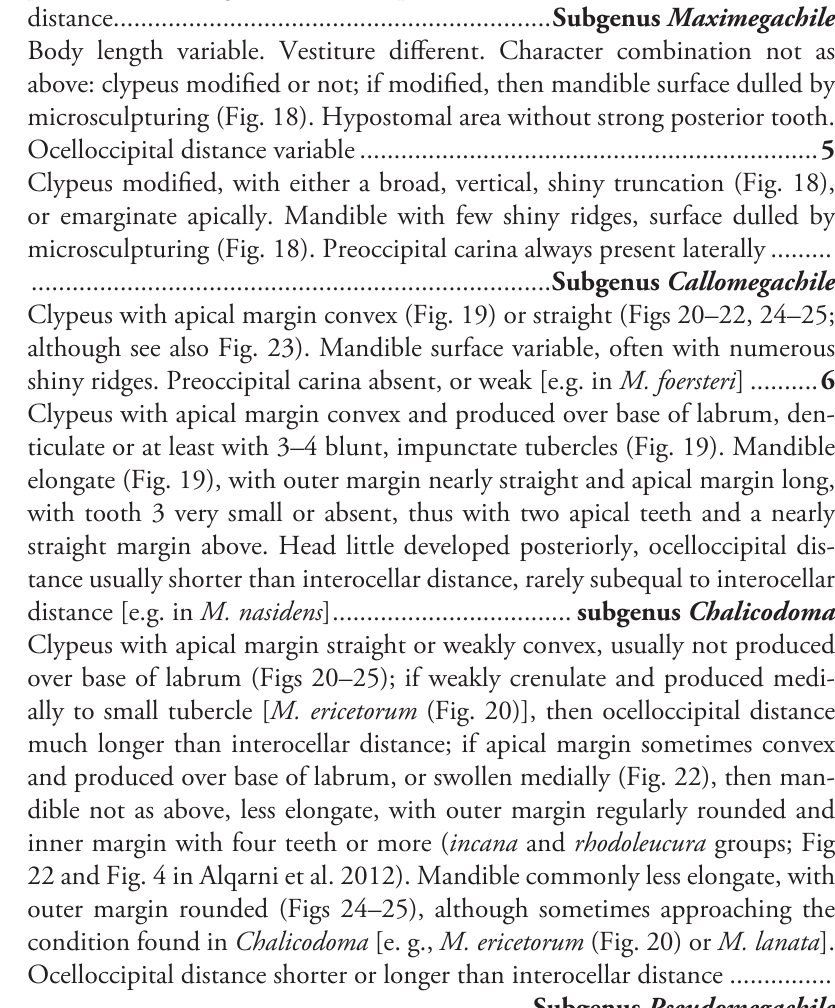
very short, truncate apically, with truncation forming a nearly vertical, shiny surface (Fig. 17). Mandible elongate, more or less parallel-sided or narrow- est preapically, with three blunt teeth (Fig. 17); mandibular ridges shiny, not dulled by microsculpturing (Fig. 17). Hypostomal area with a strong posterior tooth (Fig. 17). Ocelloccipital distance nearly twice the interocellar distance ................................................................ Subgenus Maximegachile – Body length variable. Vestiture different. Character combination not as above: clypeus modified or not; if modified, then mandible surface dulled by microsculpturing (Fig. 18). Hypostomal area without strong posterior tooth. Ocelloccipital distance variable ................................................................... 5 5 Clypeus modified, with either a broad, vertical, shiny truncation (Fig. 18), or emarginate apically. Mandible with few shiny ridges, surface dulled by microsculpturing (Fig. 18). Preoccipital carina always present laterally ......... ............................................................................ Subgenus Callomegachile – Clypeus with apical margin convex (Fig. 19) or straight (Figs 20–22, 24–25; although see also Fig. 23). Mandible surface variable, often with numerous shiny ridges. Preoccipital carina absent, or weak [e.g. in M. foersteri ] .......... 6 6 Clypeus with apical margin convex and produced over base of labrum, den- ticulate or at least with 3–4 blunt, impunctate tubercles (Fig. 19). Mandible elongate (Fig. 19), with outer margin nearly straight and apical margin long, with tooth 3 very small or absent, thus with two apical teeth and a nearly straight margin above. Head little developed posteriorly, ocelloccipital dis- tance usually shorter than interocellar distance, rarely subequal to interocellar distance [e.g. in M. nasidens ] ................................... subgenus Chalicodoma – Clypeus with apical margin straight or weakly convex, usually not produced over base of labrum (Figs 20–25); if weakly crenulate and produced medi- ally to small tubercle [ M. ericetorum (Fig. 20)], then ocelloccipital distance much longer than interocellar distance; if apical margin sometimes convex and produced over base of labrum, or swollen medially (Fig. 22), then man- dible not as above, less elongate, with outer margin regularly rounded and inner margin with four teeth or more ( incana and rhodoleucura groups; Fig 22 and Fig. 4 in Alqarni et al. 2012). Mandible commonly less elongate, with outer margin rounded (Figs 24–25), although sometimes approaching the condition found in Chalicodoma [e. g., M. ericetorum (Fig. 20) or M. lanata ]. Ocelloccipital distance shorter or longer than interocellar distance ............... ......................................................................... Subgenus Pseudomegachile 7 Basal hair on claws of all legs comparatively long, length more than 4 times its basal width, in appearance and color similar to apical hair, although shorter (Fig. 7). Mandible either 4-toothed with upper tooth broad and truncate, ap- proaching the 5-toothed condition (Fig. 30) or 5-toothed (Fig. 31); mandible with a partial cutting edge in second interspace (Fig. 30) (cutting edge often small, recessed and difficult to see; Fig. 31), and either a strongly reduced cut- ting edge or no visible cutting edge in third interspace (Figs 30–31). Scopa